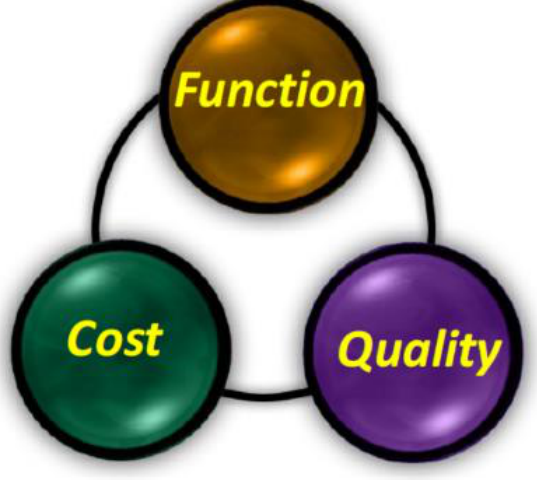
Figure 2: The three main issues of value. Source: (Al-Yousefi,